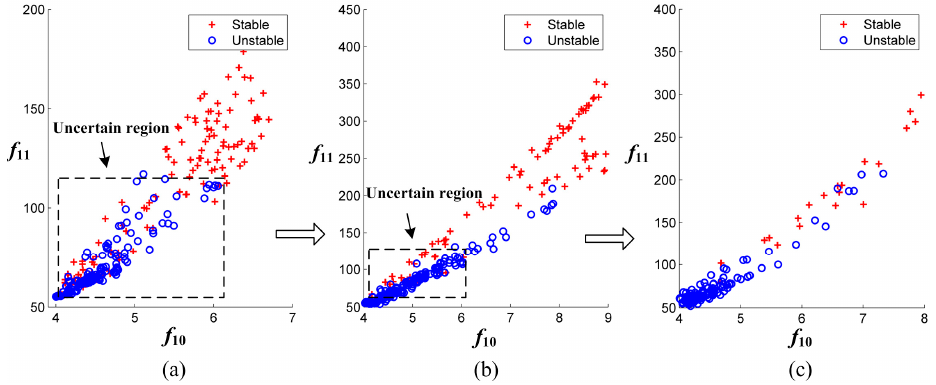
Figure 10. Feature space of f 10 versus f 11 at different response time: ( a ) t = 0.0167 s; ( b ) t = 0.5 s; and ( c ) t = 1 s.